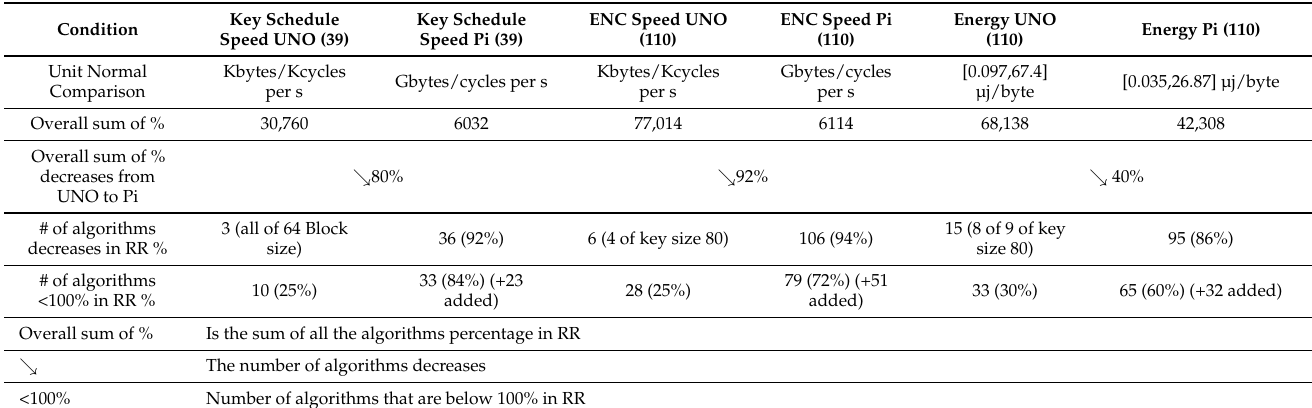
Table 4. Overall comparison of algorithms’ numbers and percentage in UNO versus